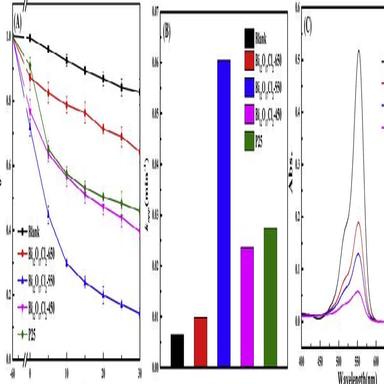
Sonocatalytic degradation of dye RhB with various samples (A), the corresponding Kapp values (B), and the variation of UV–Vis absorption spectra of RhB with the extension of reaction time (C).